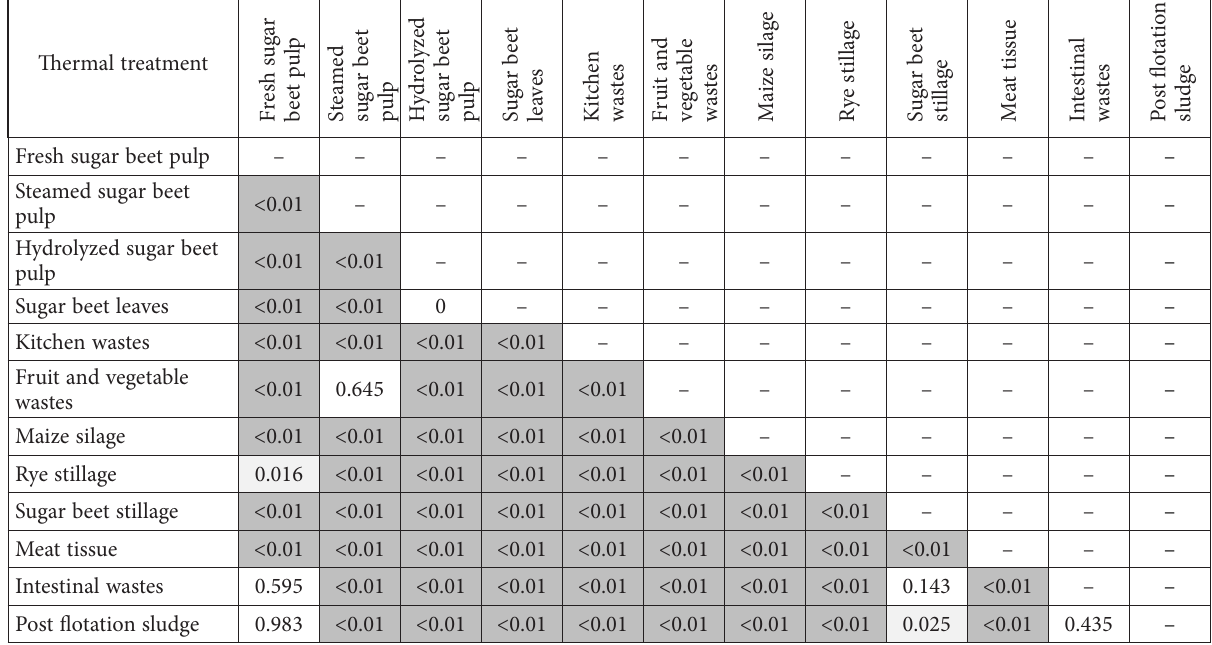
Table 3S. Statistical comparison of hydrogen production from batch test with thermal treatment (ANOVA, p value, Tukey ’ s test)